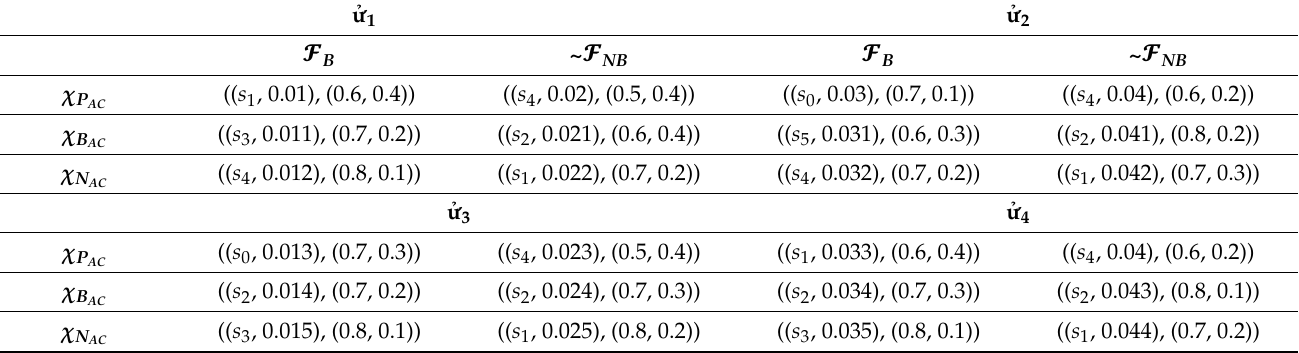
Table 8. Loss functions for D DE − 1 .